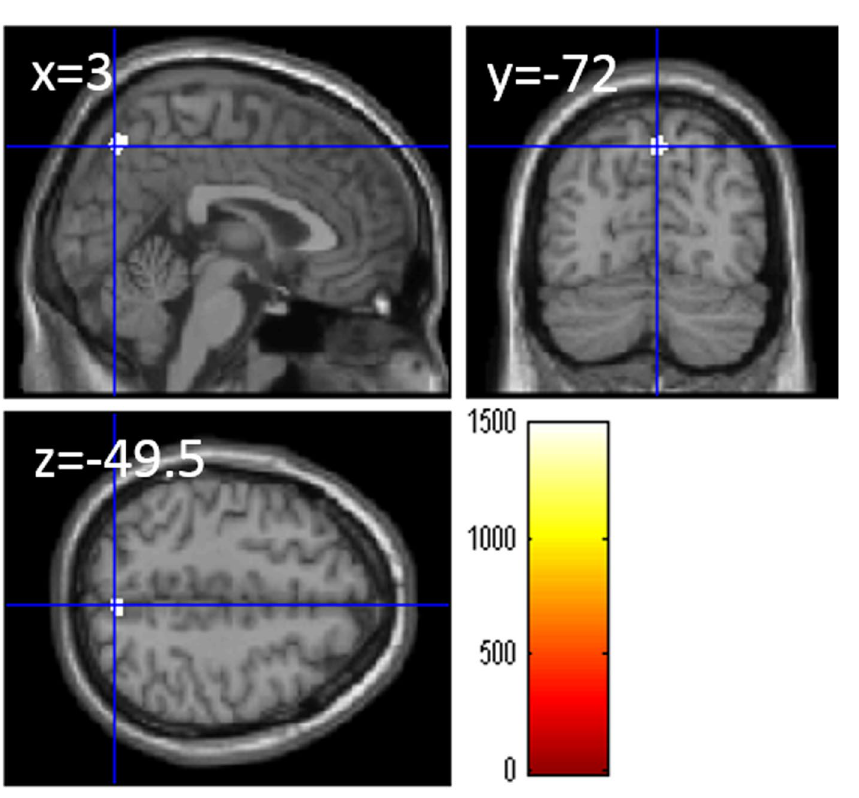
Figure 6. Relationships between simple processing speed and rGMV. Figures represent areas of significant positive correlation between TBIT perceptual factor scores and rGMV by multiple regression analysis corrected for effects of age and sex. The results shown were obtained using a threshold of TFCE, P < 0.05 corrected (FWE) based on 5000 permutations. In section images, the color bar represents TFCE values. Significant positive correlations were found in the